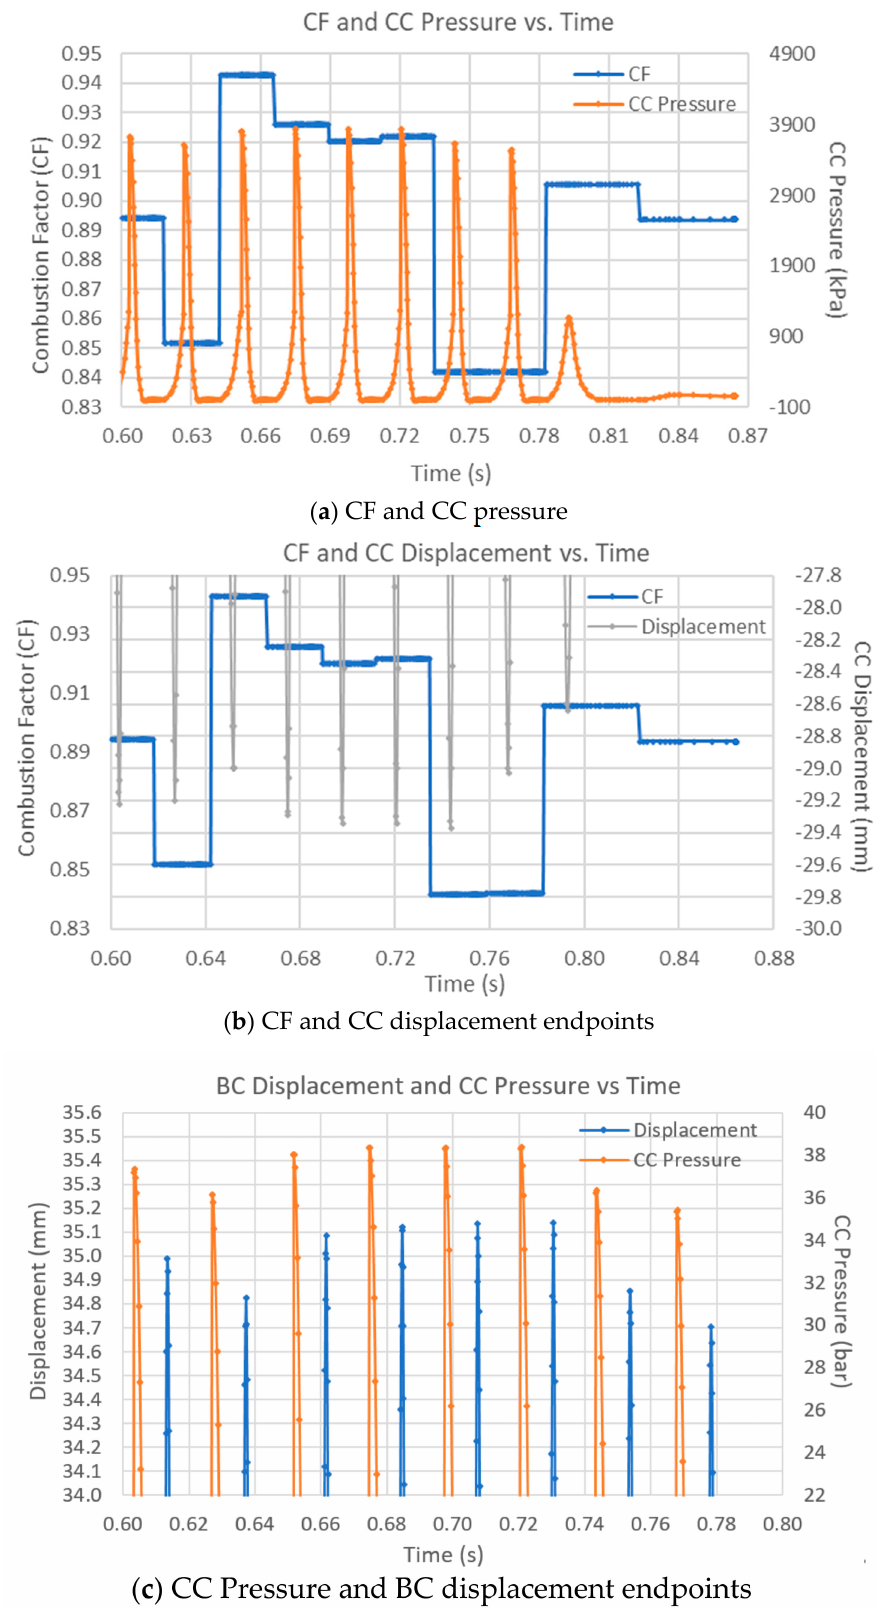
Figure 19. ( a ) CF and CC pressure vs. time, ( b ) CF and CC displacement endpoints vs. time, ( c ) CC pressure and BC displacement endpoints vs. time at 0.89 ± 10%.